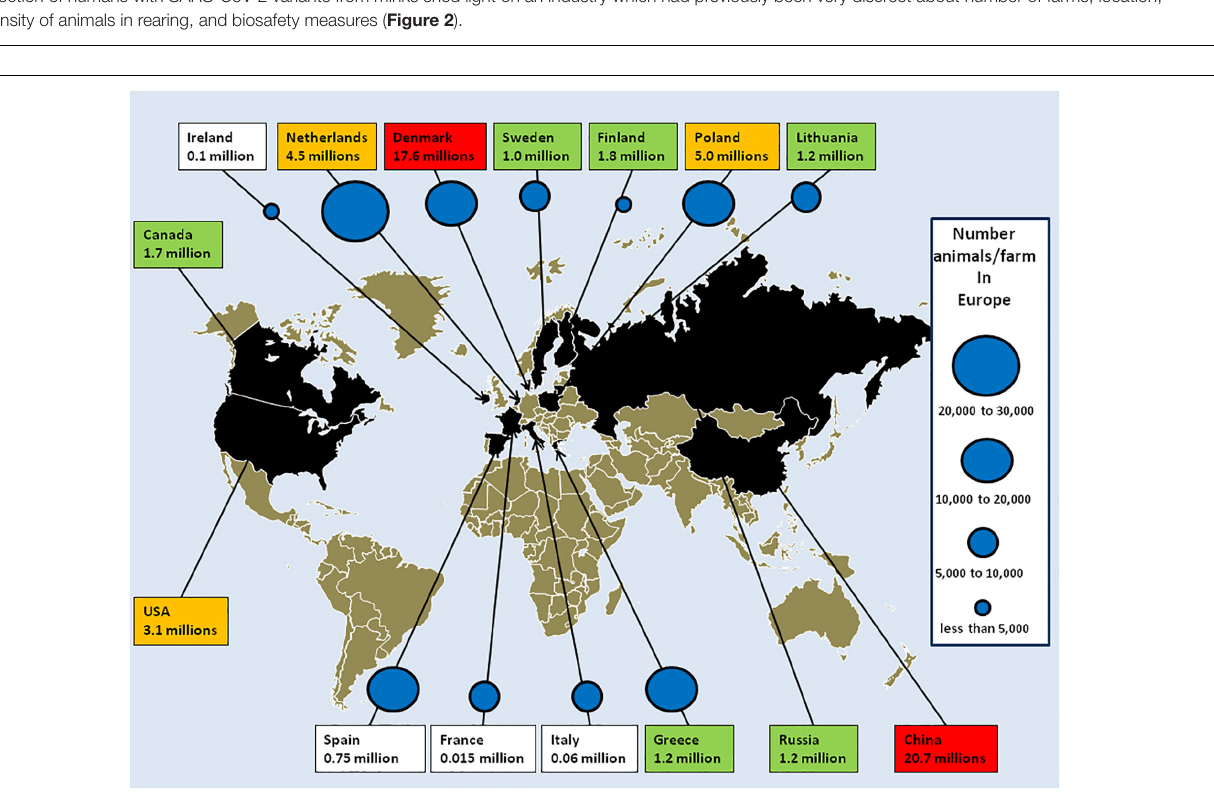
ACE2 was performed using Clustal Omega 1.2.4 1 and ACE2 Mlut shared only 83.73 and 83.48% amino acid identity with the Hsap ACE2, respectively, while the ACE2 sequences from Nvis and Mlut displayed 99.51% similarity one to the other ( Figure 4A ). The similarity between Hsap ACE2 and mink ACE2 dropped to 63.34% in the region described to be involved in the interaction with the SARS-CoV-2 spike protein (regions 30–41, 82–93, and 353–358). Despite the difference in amino acids 131 and 133 between Nvis ACE2 and Mlut ACE2, respectively,